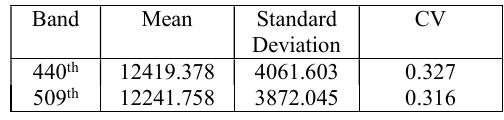
Table 1. Evaluate Results of